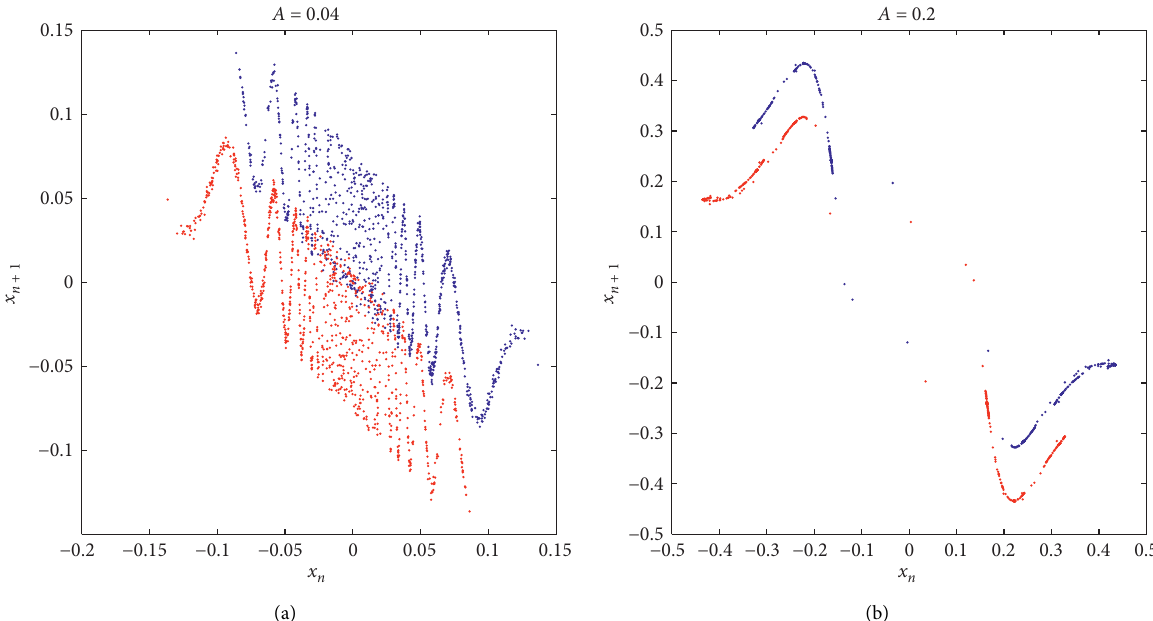
Figure 5: Two coexisting chaotic attractors for A � 0 . 04 and μ � 0 . 2 (a); two coexisting periodic attractors for A � 0 . 2 and μ � 0 . 2 (b).